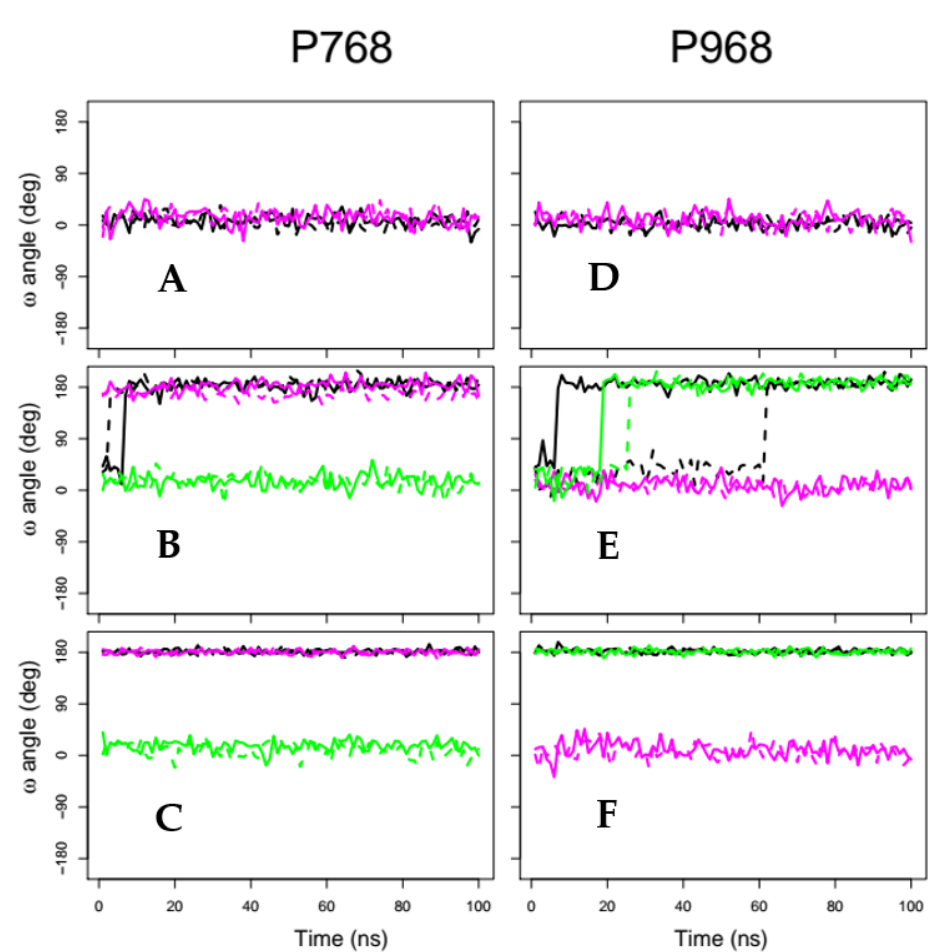
Figure 2. Global impact of X-Pro imide bond cis-trans isomerization. Variation in the X-Pro imide angle ω of P768 ( A – C ) and P968 ( D – F ) along MD trajectories. Solid and dashed curves correspond to replicas R1 and R2 of the same trajectory. The curves are colored in the following way: ( A , D ) trajec- tories with cis X-Pro imide bonds: cis (black), free (magenta); ( B , E ) trajectories with isomerization restraints using a force constant of 10 kcal/(mol.deg) tr_10 (black), tr768_10 (magenta), and tr968_10 (green) (several transitions of P768 and P968 are visible during the trajectories); ( C , F ) trajectories with isomerization restraints using a force constant of 100 kcal/(mol.deg): tr_100 (black), tr768_100 (magenta), and tr968_100 (green). For clarity, only one point in every 100 frames is